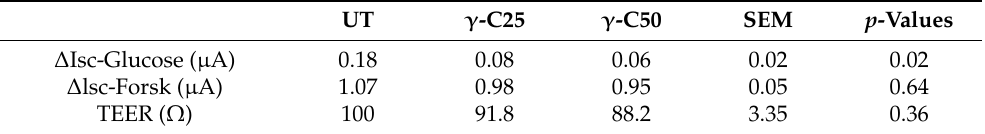
Table 1. D-glucose-induced Δ Isc (µA) and transepithelial resistance (TEER) measured on IPEC-J2 cell line incubated 24 h with 0.25 mg/mL ( v / v , γ -C/culture medium, γ -C25) and 0.50 mg/mL ( v / v